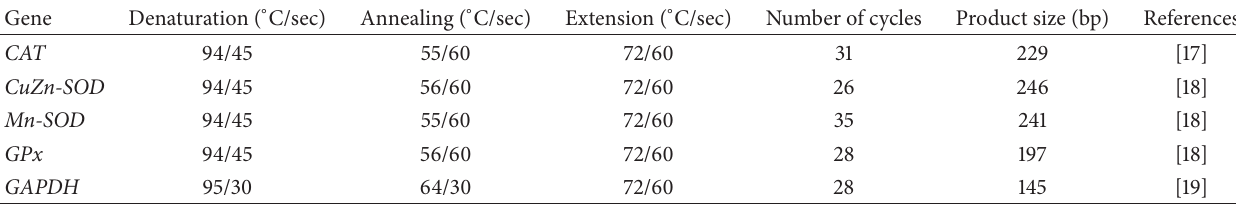
Table 2: PCR programs for mouse CAT, CuZn-SOD, Mn-SOD, GPx, and